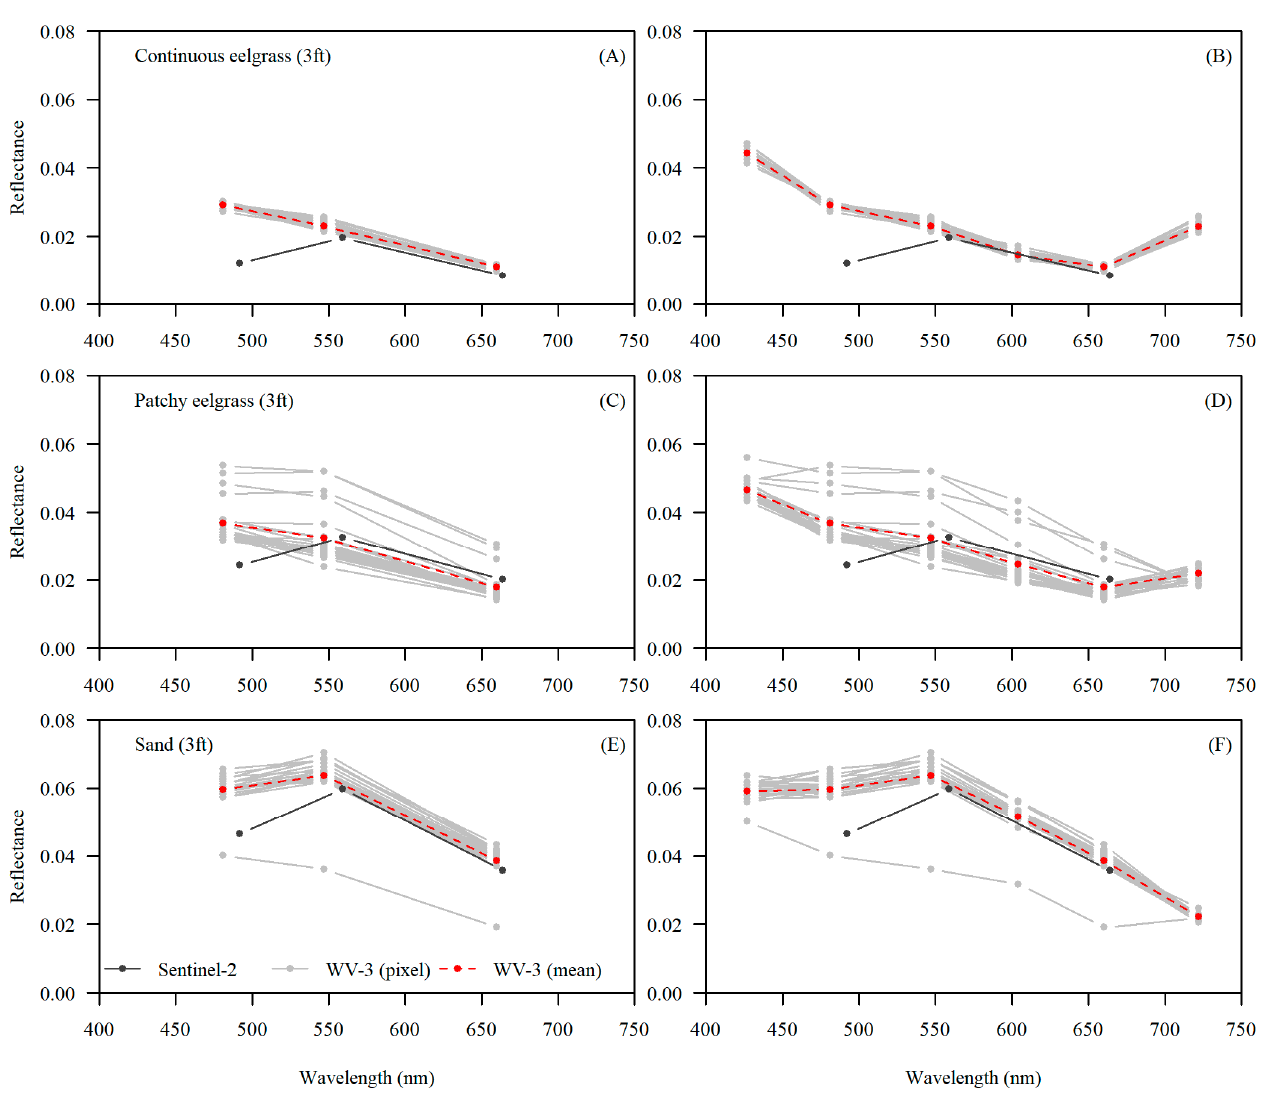
Figure 7. Spectra for three habitat types: continuous eelgrass ( A – B ), patchy eelgrass ( C – D ) and sand ( E – F ) at the same depth (3 ft) for one Sentinel-2 pixel and all corresponding WorldView-3 pixels (WV-3 pixel) from the 11 August 2019 image. Left column corresponds to the common bands between sensors, right column compares the full spectral resolution of WorldView-3 (excluding NIR bands) to the three Sentinel-2 bands. Top row is a continuous eelgrass (vegetation) bed, middle row is a patchy eelgrass bed with dense eelgrass patches mixed with bare sand, bottom row is non vegetated sandy habitat. Red dashed line is the mean spectra of all WorldView-3 spectra (WV-3 mean).